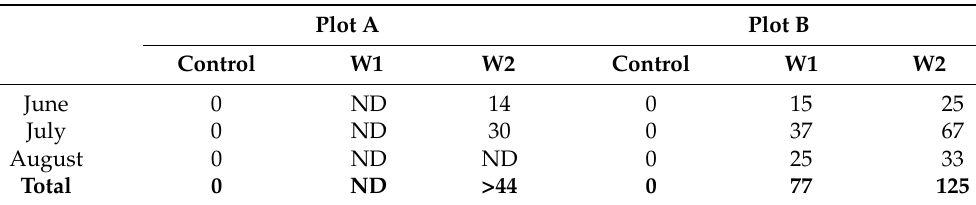
Figure 2. Illustration of irrigated test fields with the three irrigation areas and the subplots’ locations for measurements ( A , B ). Table 2. Amount of water distributed for each tests plot (in millimeters). ND refers to no data. (W1: low irrigation, W2: high irrigation).